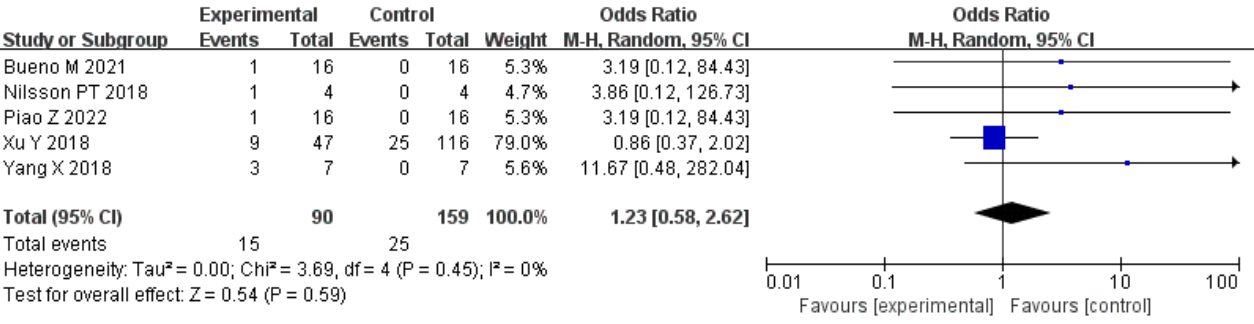
Figure 10. Meta-analysis of PAHs/VOCs and rubber asphalt. The solid horizontal lines indicate the 95% CI. The size of blue squares indicates weight of study in the analysis. The black diamond with indicates the pooled odds ratio estimate, with 95% CI represented by the diamond width.